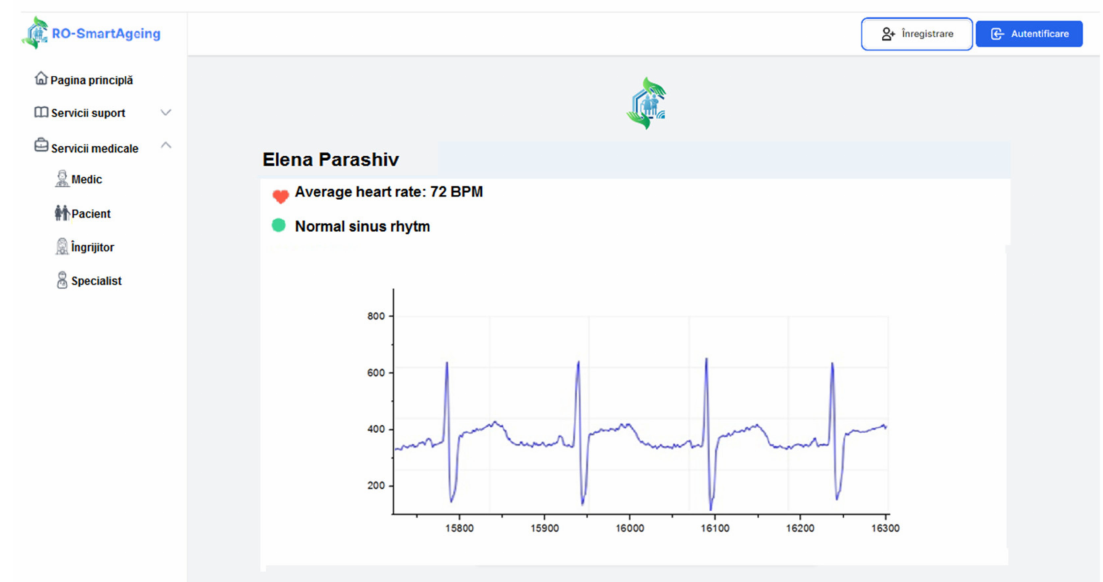
Figure 9. Measured ECG with the Medical Blackbox displayed on the RO-SmartAgeing platform.